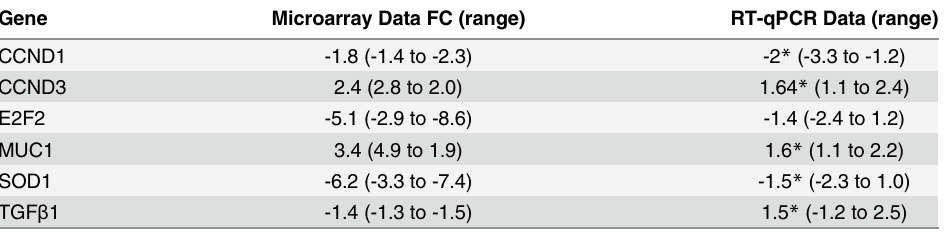
Table 7. Real time PCR validation of microarray expression data using select genes in the whole blood of workers exposed to MWCNTs.